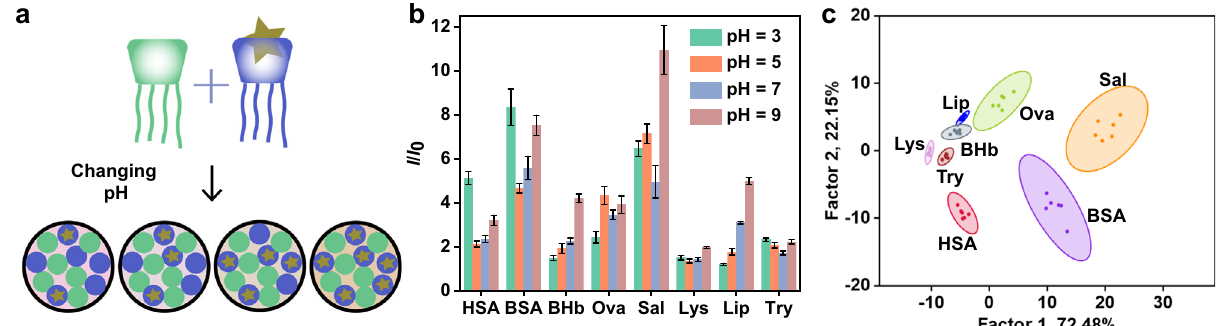
Fig. 7 Construction and experimental results of sensor array based on changing the environmental factor. a Schematic diagram of SA9 . Pattern recognition of proteins using SA9 ([GC5A] = [CD] = 1.0 μ M, [AlPcS 4 ] = 1.0 μ M). b Fluorescence response patterns of the sensor array against various proteins (23.8 μ g/mL for each protein). The order of colored symbols from top to bottom in the legend corresponds to the column order of histogram from left to right. c Canonical score plot for the two factors of simpli fi ed fl uorescence response patterns obtained from LDA with 95% con fi dence ellipses. Error bars in b represent mean ± s.d. ( n = 6